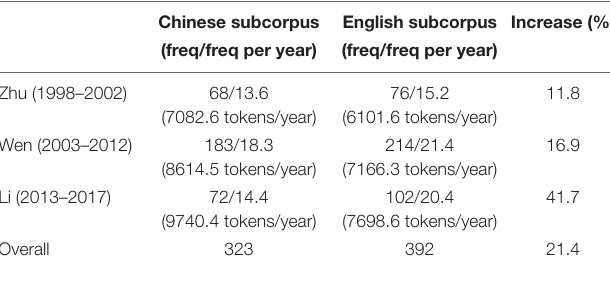
TABLE 5 | Reform*/restructur* in both subcorpora and across the